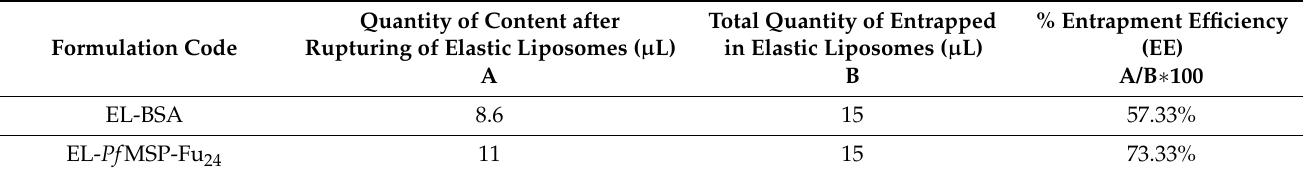
Table 6. The entrapment efficiency of bovine serum albumin (BSA) and Plasmodium falciparum asexual blood-stage surface antigen fusion protein ( Pf MSP-Fu 24 )-loaded elastic liposomes.